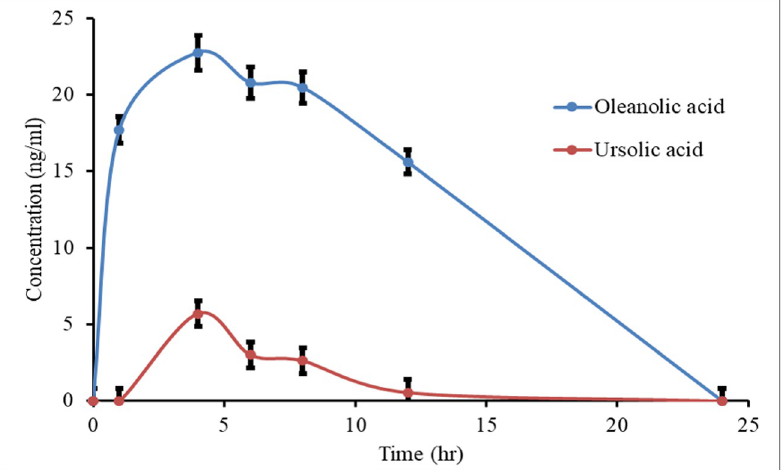
Fig 2. Concentration vs. time profile of UA and OA. Both drugs showed maximum plasma concentration at 4 h and could not detect at 24 hr in plasma.